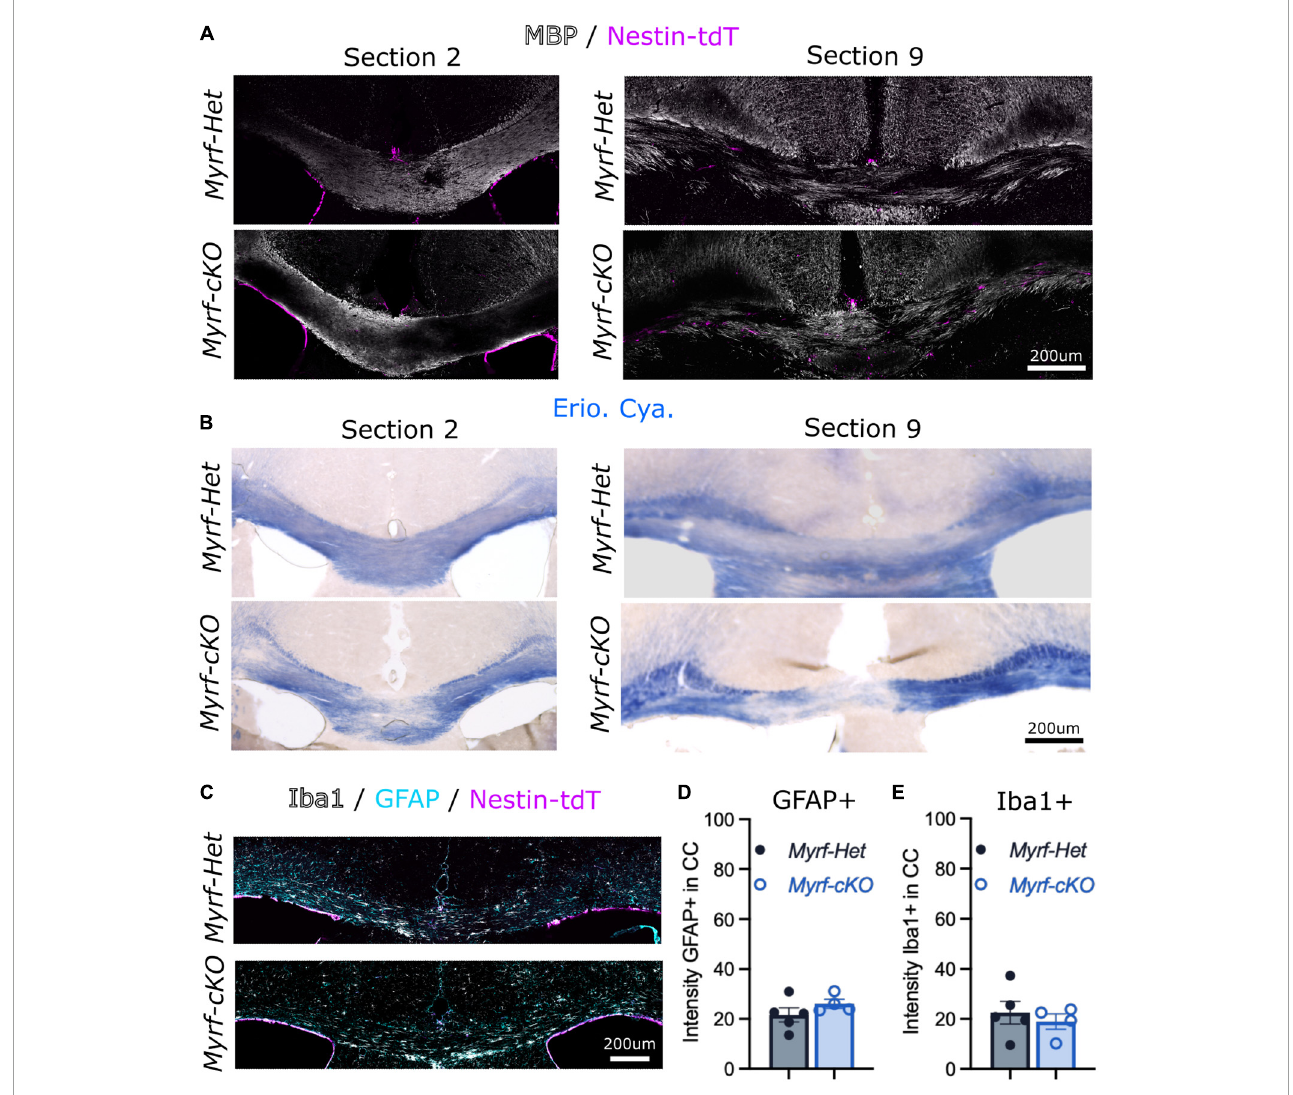
FIGURE2 Cuprizone diet induce similar demyelination of the corpus callosum when parenchymal oligodendrocyte progenitor cells (pOPCs) differentiation is blocked. (A,B) Representative images of Myrf-Het;Nestin-tdT and Myrf-cKO;Nestin-tdT coronal brain sections (A) immunostained for MBP (in white) and Nestin-tdT (magenta) or (B) stained with Eriochrome Cyanine (Erio. Cya., in blue) after a 6-week cuprizone diet (sections 2 and sections 9 of the same animals). (C) Representative images of Myrf-Het;Nestin-tdT and Myrf-cKO;Nestin-tdT coronal brain sections immunostained for Iba1 (in white), GFAP (in cyan) and Nestin-tdT (in magenta) after a 6-week cuprizone diet. (D) Quantification of the GFPA+ intensity in the CC of Myrf-Het;Nestin-tdT and Myrf-cKO;Nestin-tdT brain sections ( n = 4–5, error bars = sem, Student’s t -test). (E) Quantification of the Iba1+ intensity in the corpus callosum